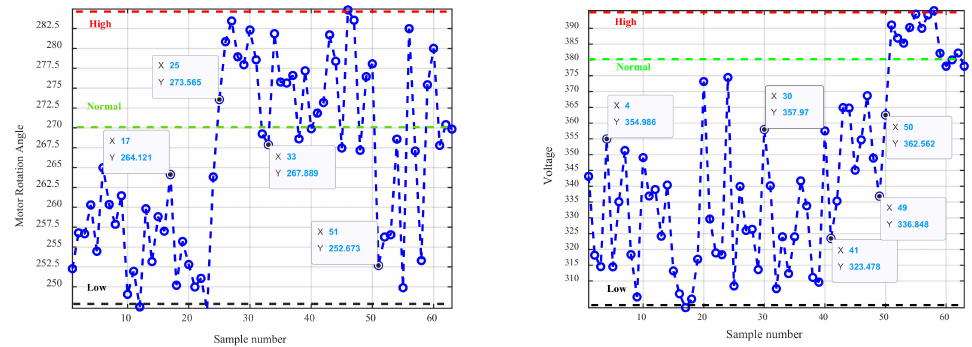
Figure 9. Data graph.